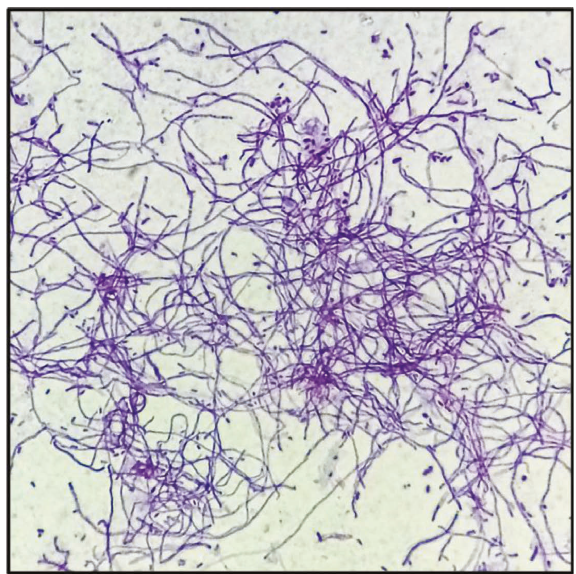
Figure 3: Representative photomicrograph of Gram stain of isolated Streptomyces (1000 x